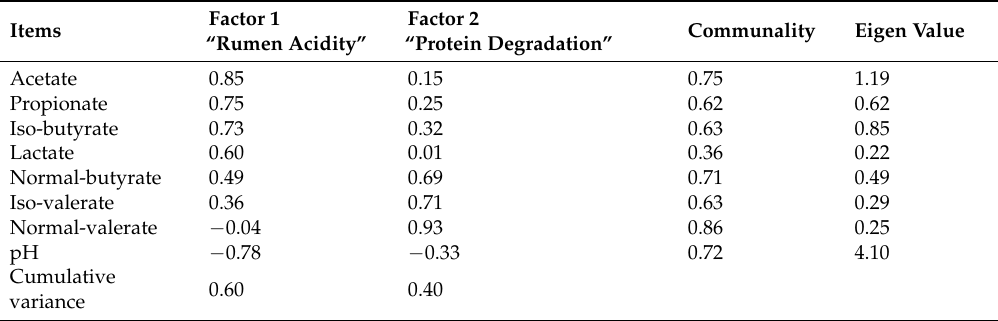
Table 2. Rotated latent explanatory factor pattern and the proposed factor